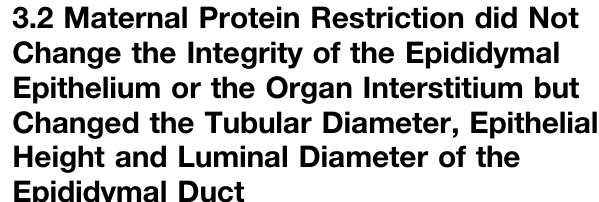
Frontiers in Cell and Developmental Biology |